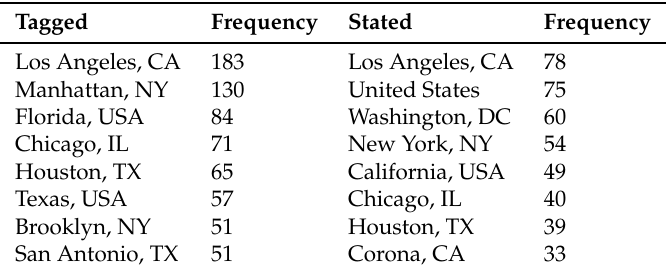
Table 5. Location variables (tagged and stated